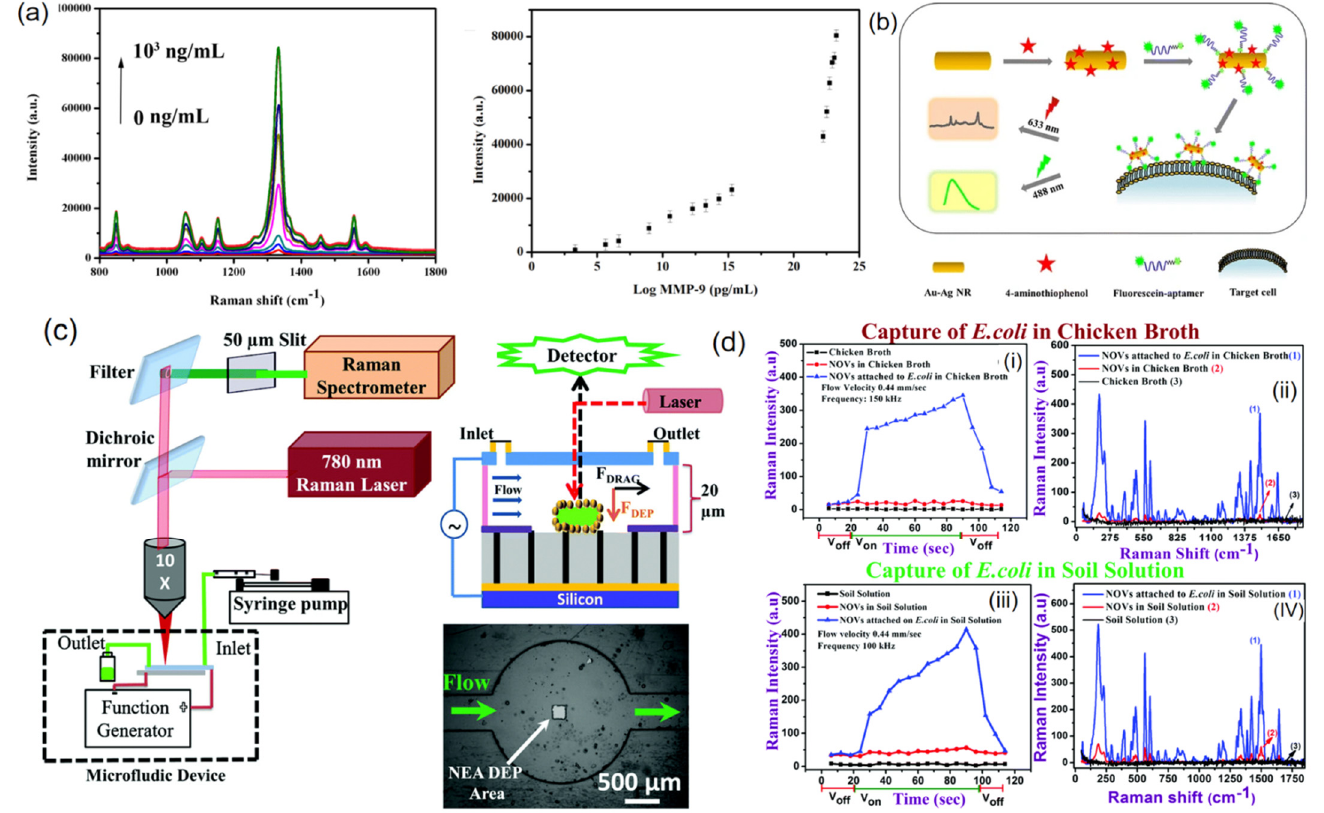
Figure 5. ( a ) SERS spectra of sandwich immune complexes based on AgNPs SERS tags and magnetic microspheres. ( b ) Schematic illustration of the dual mode nanotag preparation and target cell de- tection. ( c ) Schematic diagram of a microfluidic dielectric electrophoresis device for the detection of bacteria under a Raman microscope. ( d ) DEP capture in Escherichia coli cells was assessed by fluores- cence and Raman measurements in different complex substrates. ( a ) Reproduced with permission of Ref. [42], Copyright 2019, Elsevier B.V. ( b ) Reproduced with permission of Ref. [43], Copyright 2015, published by Springer Nature. ( c , d ) Reproduced with permission of Ref. [44], Copyright 2015,